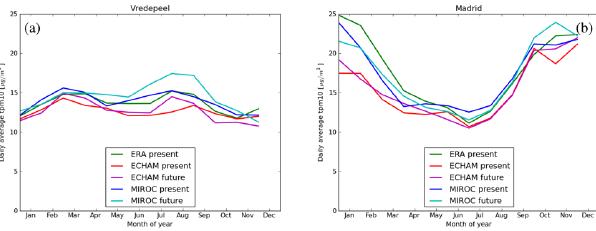
Fig. 11. Simulated daily mean PM 10 concentrations for Vredepeel (a) and Madrid (b) averaged over